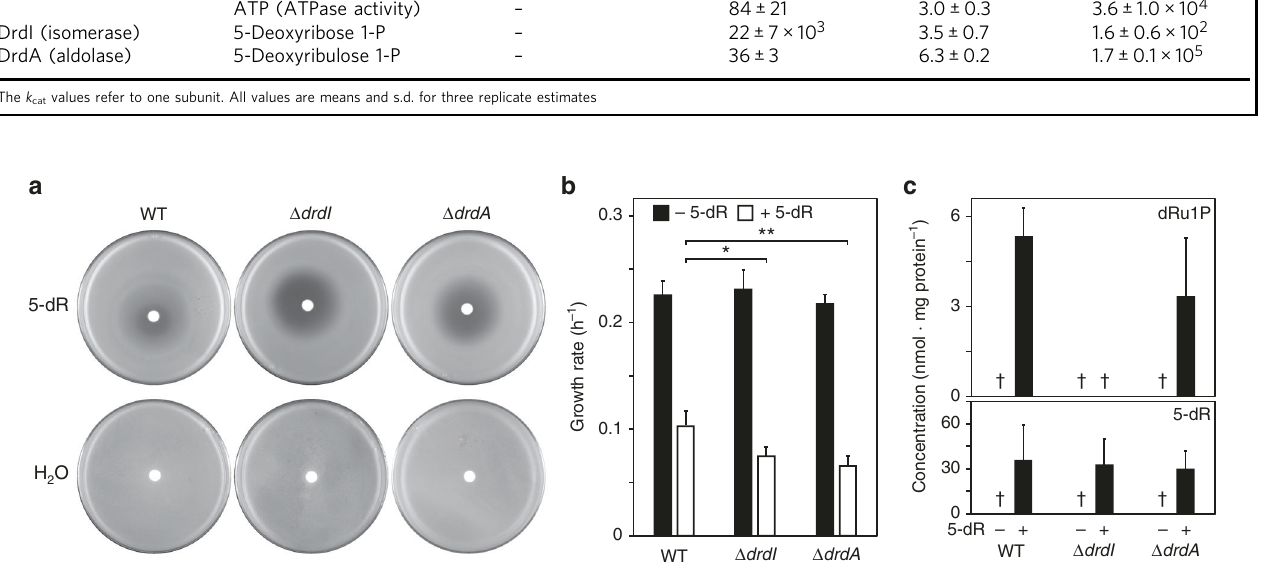
Fig. 3 Growth and metabolic phenotypes of drdA and drdI deletant strains. a Deleting drdA or drdI exacerbates 5-deoxyribose toxicity. A disc containing 10 µ L of 1 M 5-deoxyribose was applied to lawns of B. thuringiensis wild type (WT) or deletant cells. Note the larger zone of growth inhibition for the deletant strains. b Similarly, adding 1 mM 5-deoxyribose (5-dR) to liquid medium reduced the growth rate of the deletant strains signi fi cantly more than the wild type. Data are means of four replicates or three replicates for the Δ drdI strain; error bars are the s.d. Signi fi cance was determined by t -test, * P < 0.05, ** P < 0.01. c Estimated levels of dRu1P and 5-dR in cells grown to an OD 600 of ~1.7, minus or plus 1 mM 5-dR. Data are means of 7 – 11 replicates; error bars are the s.d. † level below the limit of quantitation (~1.5 nmol mg protein − 1 )